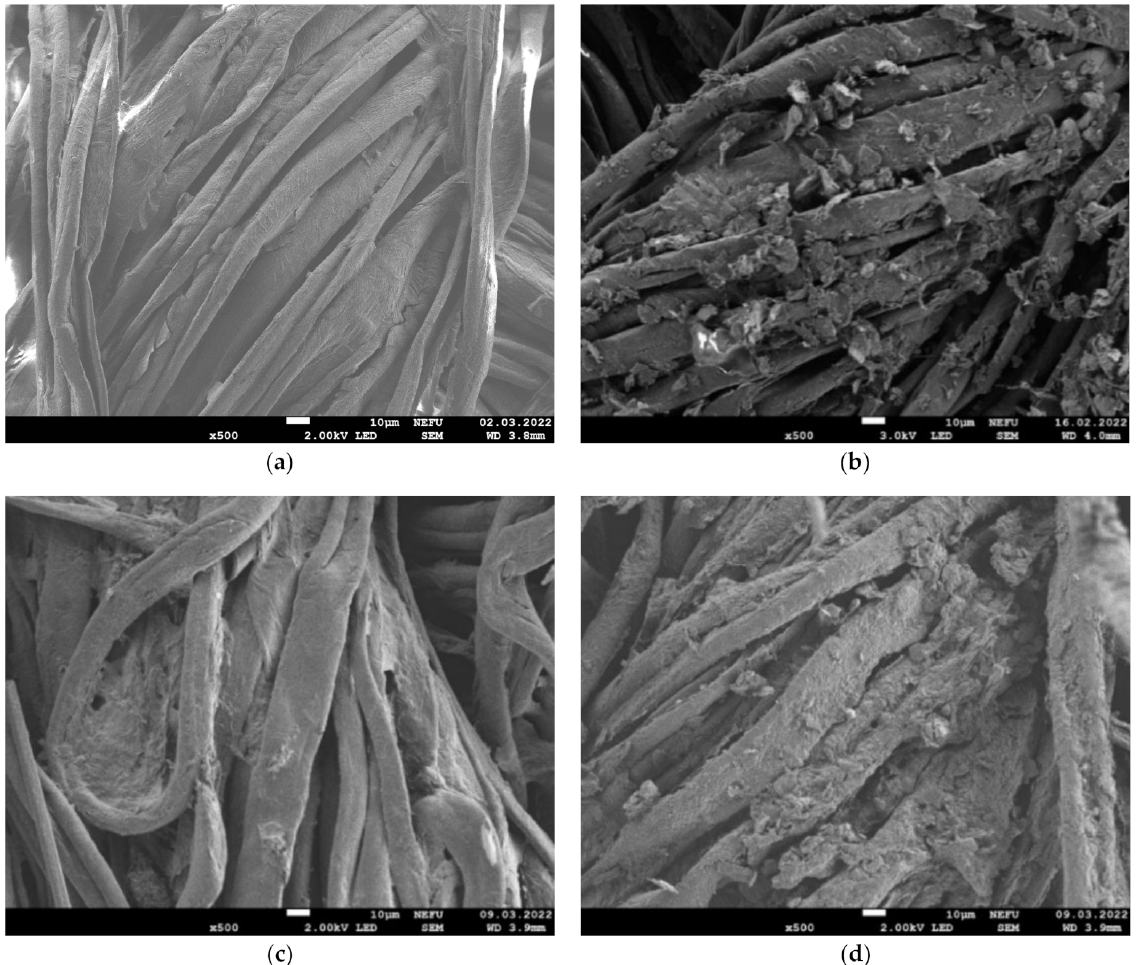
Figure 6. SEM images of the e-textile surface at 500 × magnification: ( a ) GO after 1 coating cycle; ( b ) MOG after 1 coating cycle; ( c ) GO after 10 coating cycles; ( d ) MOG after 10 coating